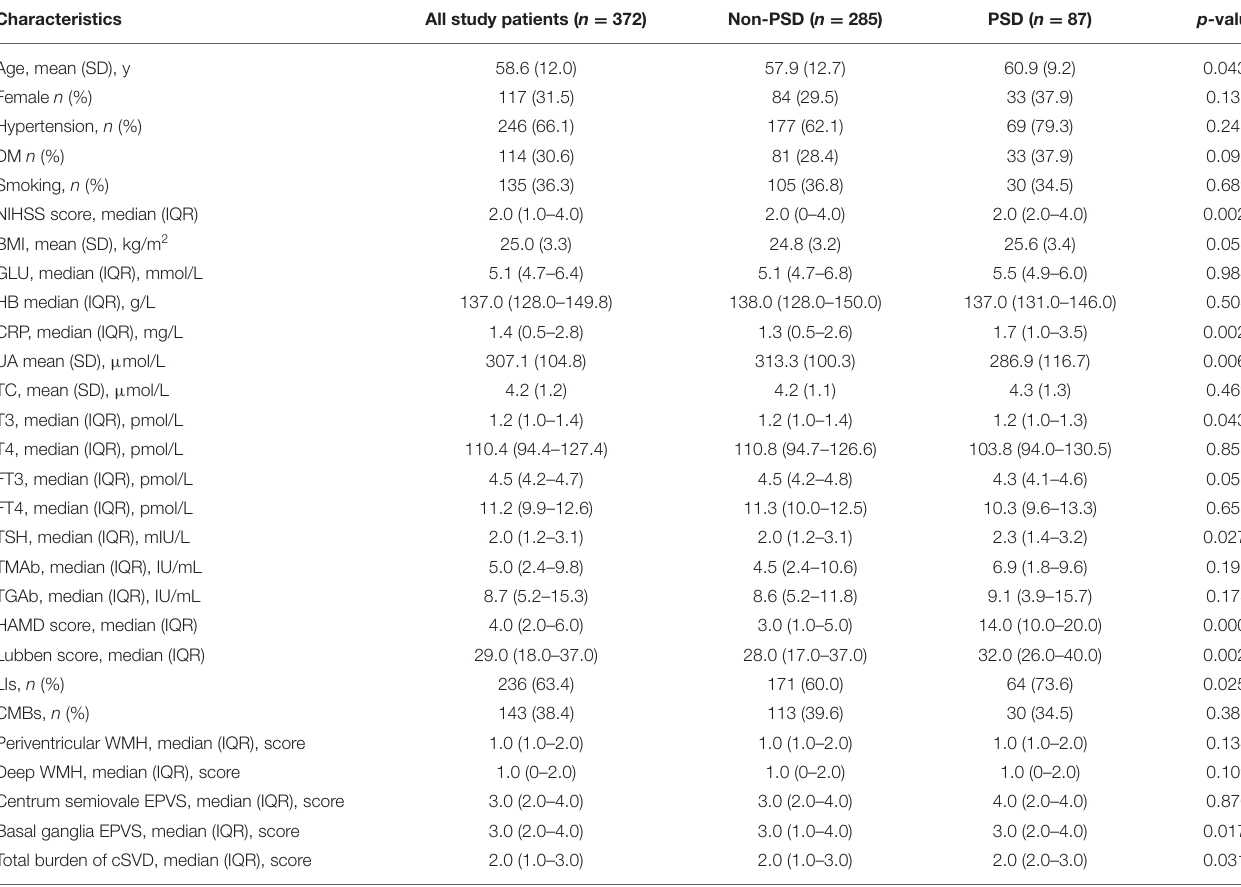
TABLE 1 | Baseline characteristics of study participants without and with PSD. Characteristics